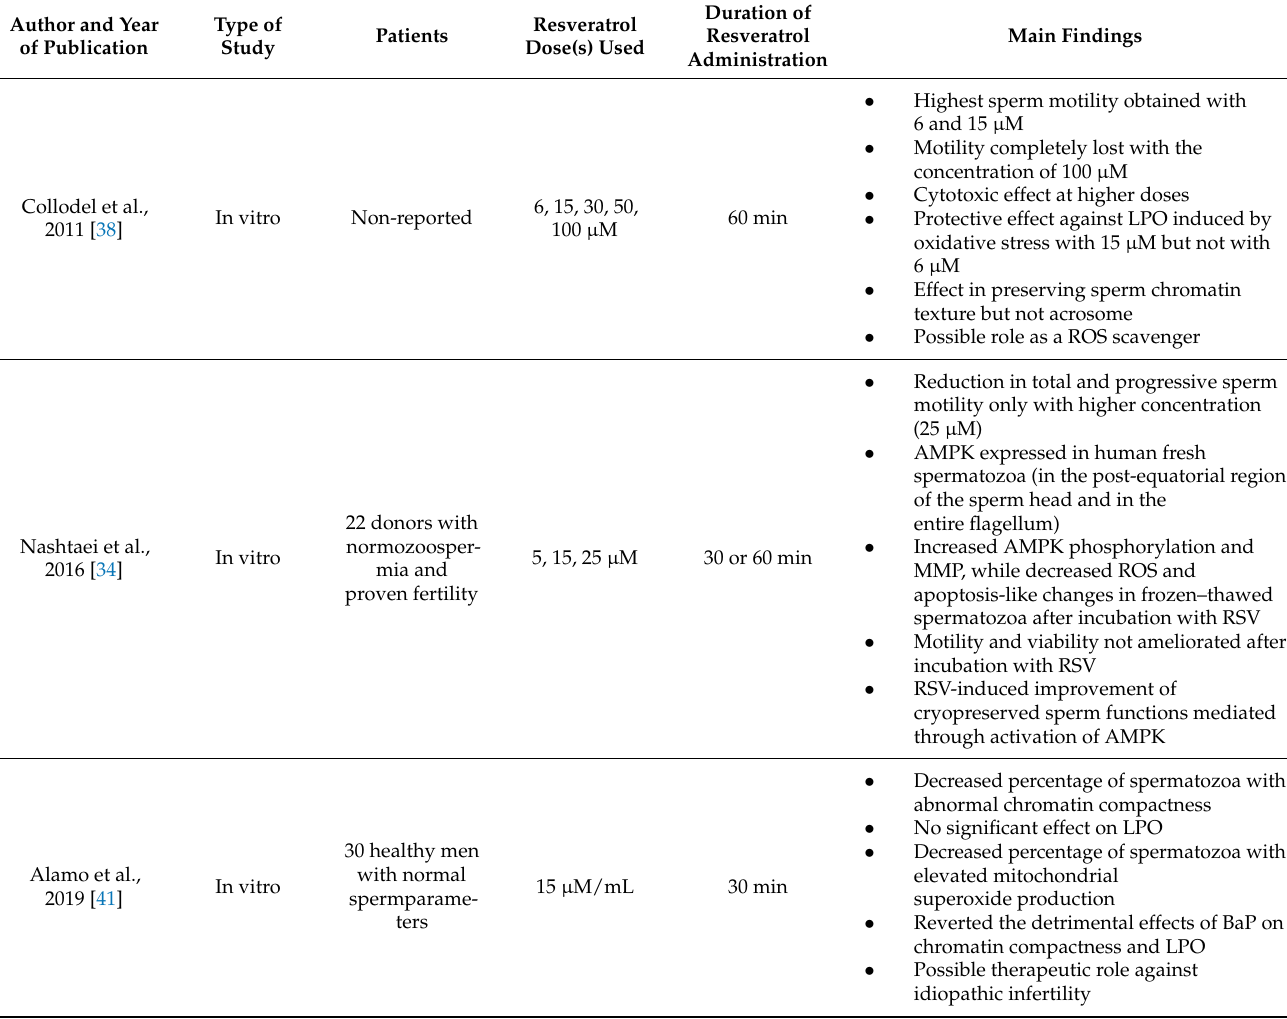
Table 1. Summary of the main studies on the effects of resveratrol on male